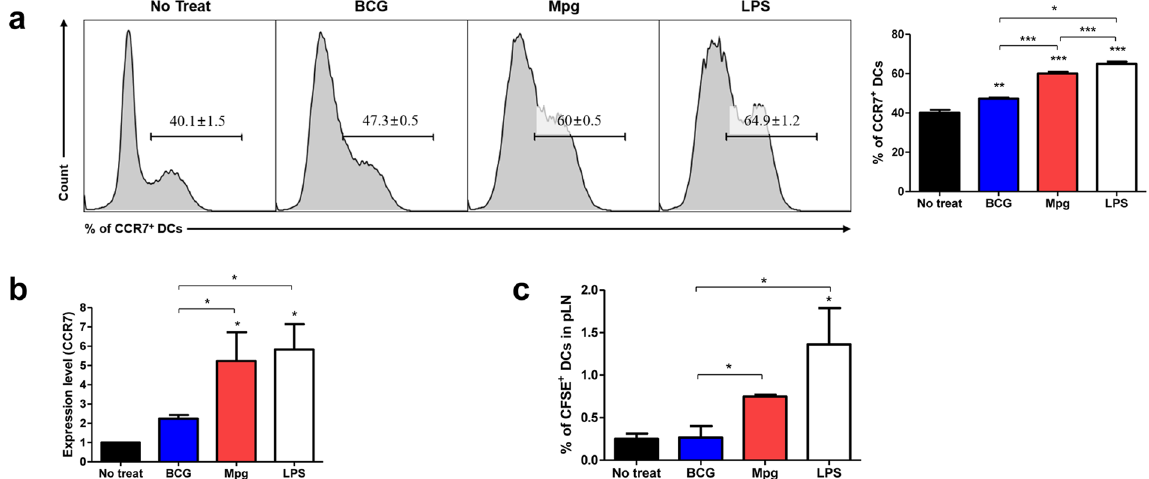
Figure 4. M. paragordonae (Mpg) induced enhanced BMDC migration. Expression levels of CCR7 protein and mRNA were measured by ( a ) flow cytometry and ( b ) qRT-PCR, respectively. To show the rate of CCR7 + BMDCs, representative histograms of CD11c-gated cells are presented and the expression levels denote the relative fold changes based on β -actin ( * P < 0.05, ** P < 0.01, *** P < 0.001; Student’s t -test). ( c ) In vivo migration of the infected BMDC with BCG or Mpg was measured by comparisons of CFSE-labeled BMDCs in popliteal lymph nodes (pLN) 2 days after injection of the BCG- or Mpg-infected BMDCs into mice footpad. The CFSE-labeled BMDCs among the CD11c + cells in popliteal lymph node were measured by flow cytometry. The mean percentile of the CFSE-labeled BMDCs in the popliteal lymph nodes from separated experiments are presented ( * P < 0.05; Student’s t -test).